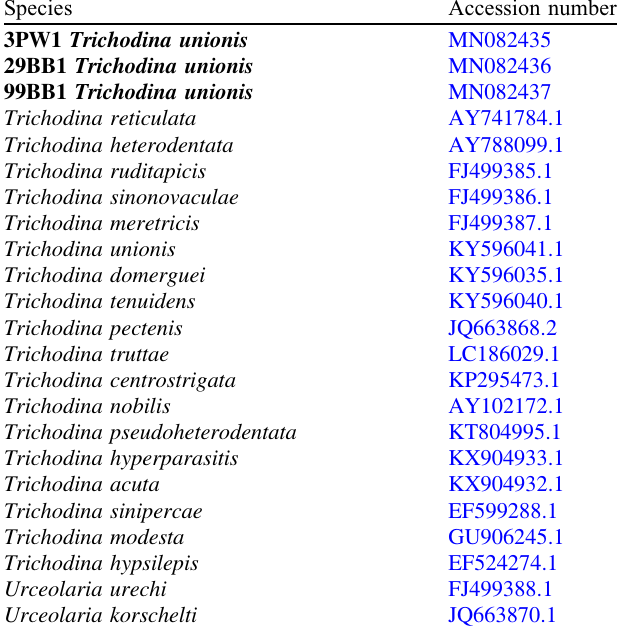
Table 1. Sequence data for the 18S rRNA region of the current trichodinids (bold taxa) and trichodinids from the NCBI database used for molecular phylogenetic